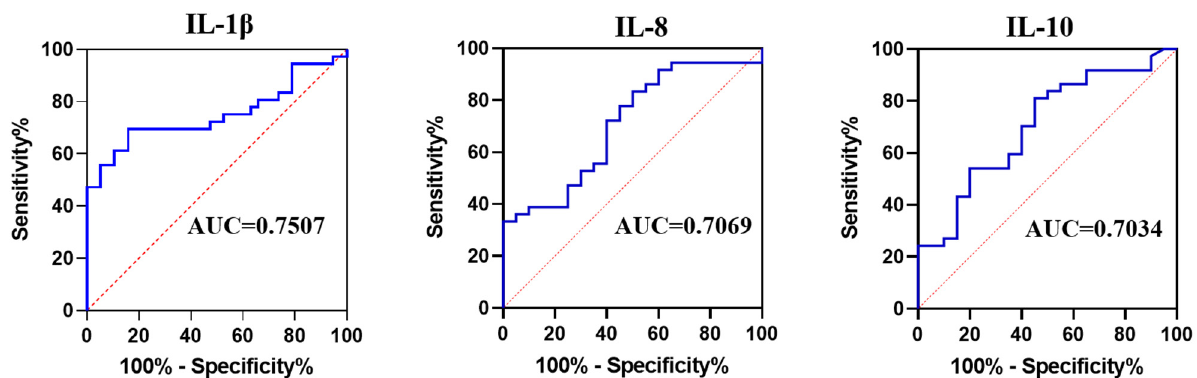
Figure 3. Receiver Operating Characteristic curves (ROCs) and area under curves (AUC) of partial synovial fluid interleukin in distinguishing between PJI and active RA. Table 2. Sensitivity and Specificity of inflammatory markers.